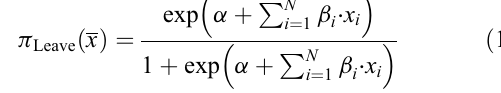
Note: 1. The number of vessels includes all vessels registered in Denmark. All other numbers are only for active commercial vessels, with an active commercial vessel in 2012 having an annual turnover of more than DKK 250,000, with this limit being corrected for in fl ation. Special fi sheries includevesselsspecializedinmusselsandhorseshrimp.Pro fi tisafterinterestandremunerationtoworkingownersbutbeforetaxes.Rateofreturnis pro fi t in percentage of assets, excluding the value of fi shing rights. FT employment is the number of working days on commercial active vessels divided by 220 days per person. Annual income is known from tax authorities and includes the full income ( fi shing and other income) of fi shermen employed on a Danish fi shing vessel for whom more than 60% of their total income comes from fi shing. 2. In the published Account Statistics for Fishery, the 18-m length reported is used as the statistical limit between vessel groups. In the empirical analysis performed below, however, 17m is used as the limit because legally, only vessels below 17 m can participate in the voluntary coastal fi shermen